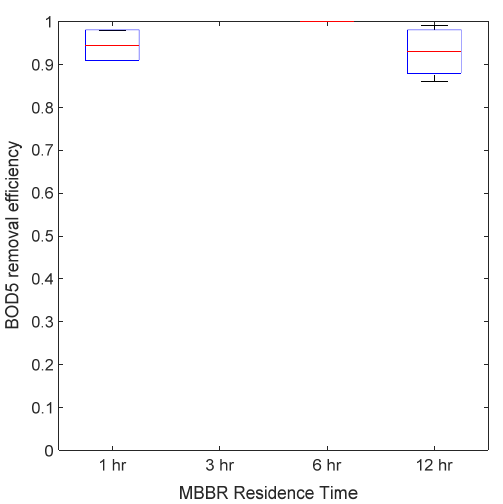
Figure 12. Average BOD 5 removal efficiency versus MBBR residence time.